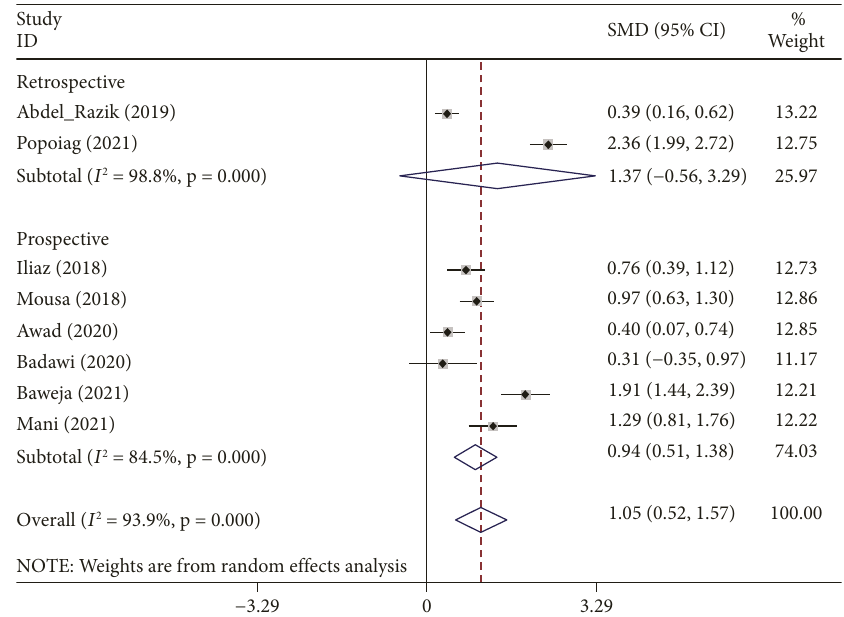
Figure 5: Subgroup analysis of differences in the NLR level between cirrhotic patients with ascites who developed SBP had elevated levels of the NLR compared to those who did not, according to the study design.